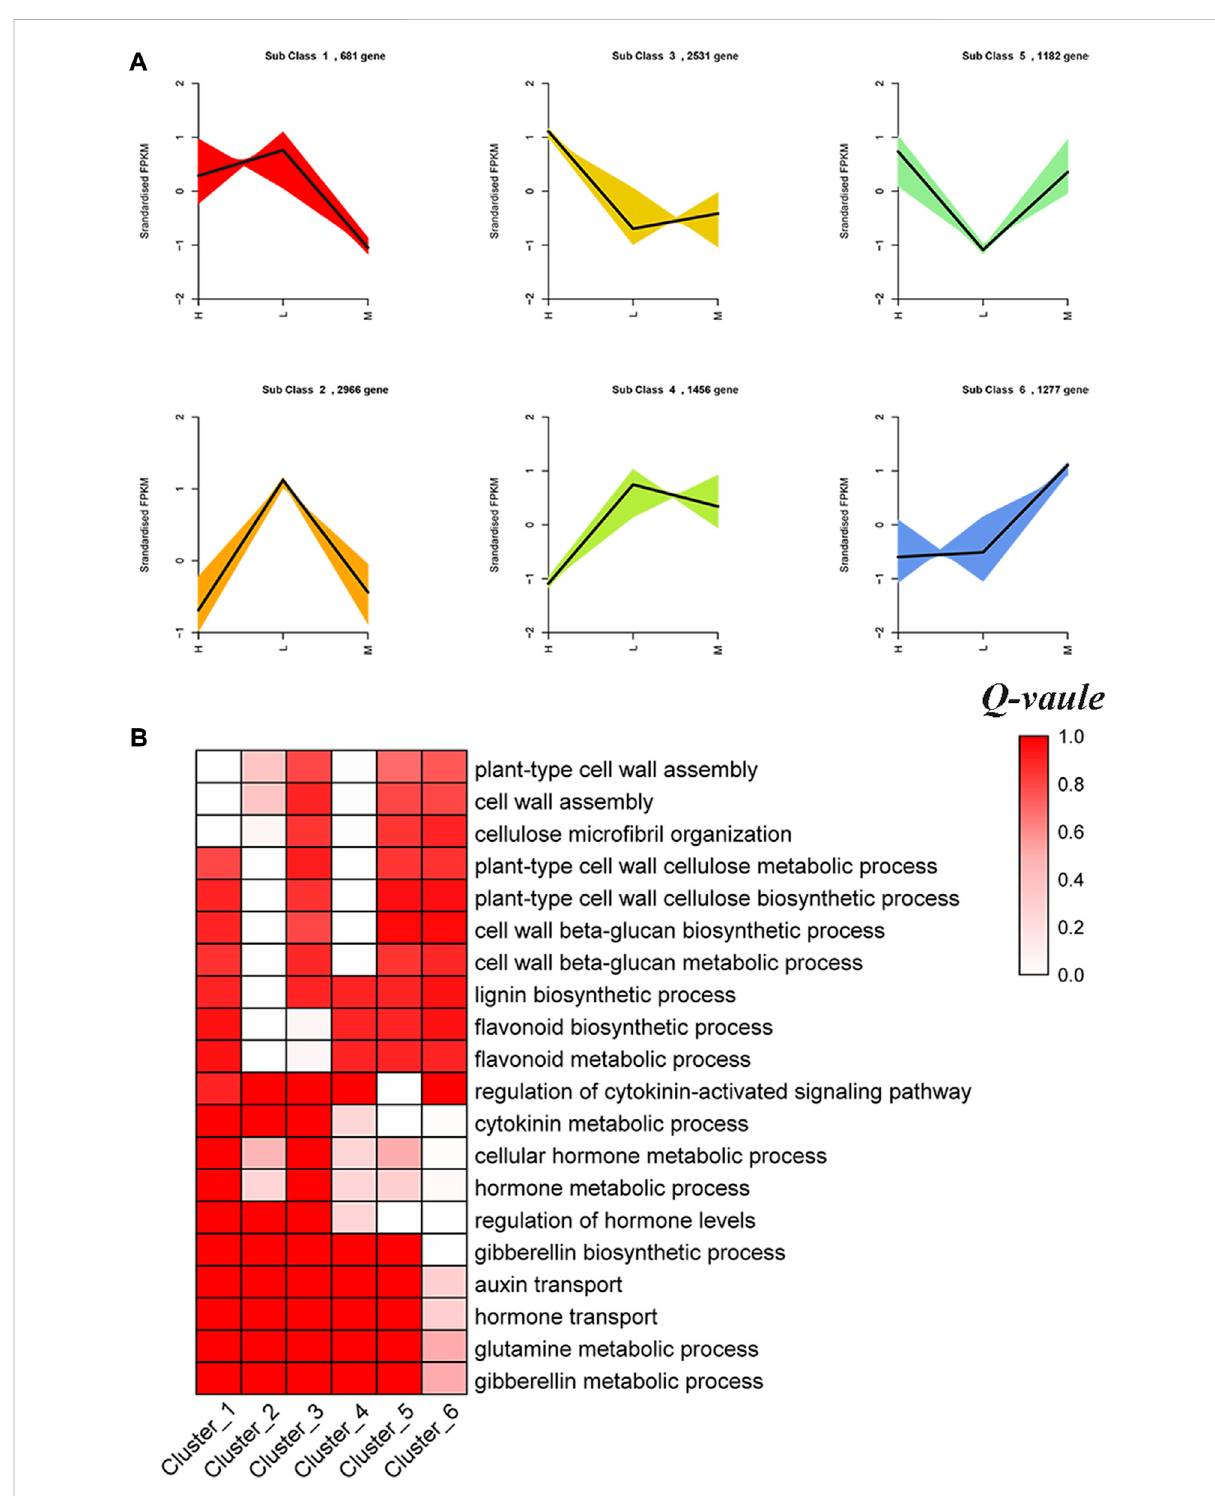
FIGURE 5 Cluster analysis of stem lodging resistance – related DEGs. (A) Six clusters show the analysis results of the gene expression pro fi les with the K-meansalgorithm. (B) GOenrichmentanalysisoftheDEGsineachcluster. Q-value meansenrichmentfactor,where0.0isnoenrichmentand1.0is highly enriched. Validation of DEGs by quantitative real-time PCR